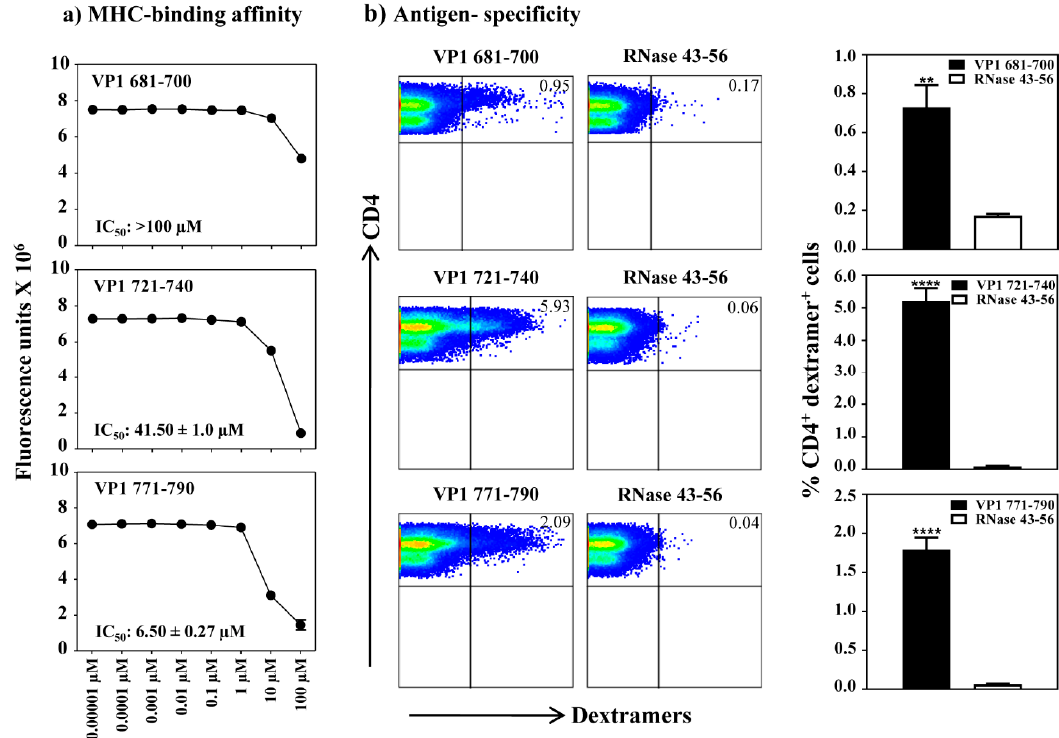
Figure 3. Determination of MHC-II binding affinities of VP1 epitopes and antigen-specificity of T